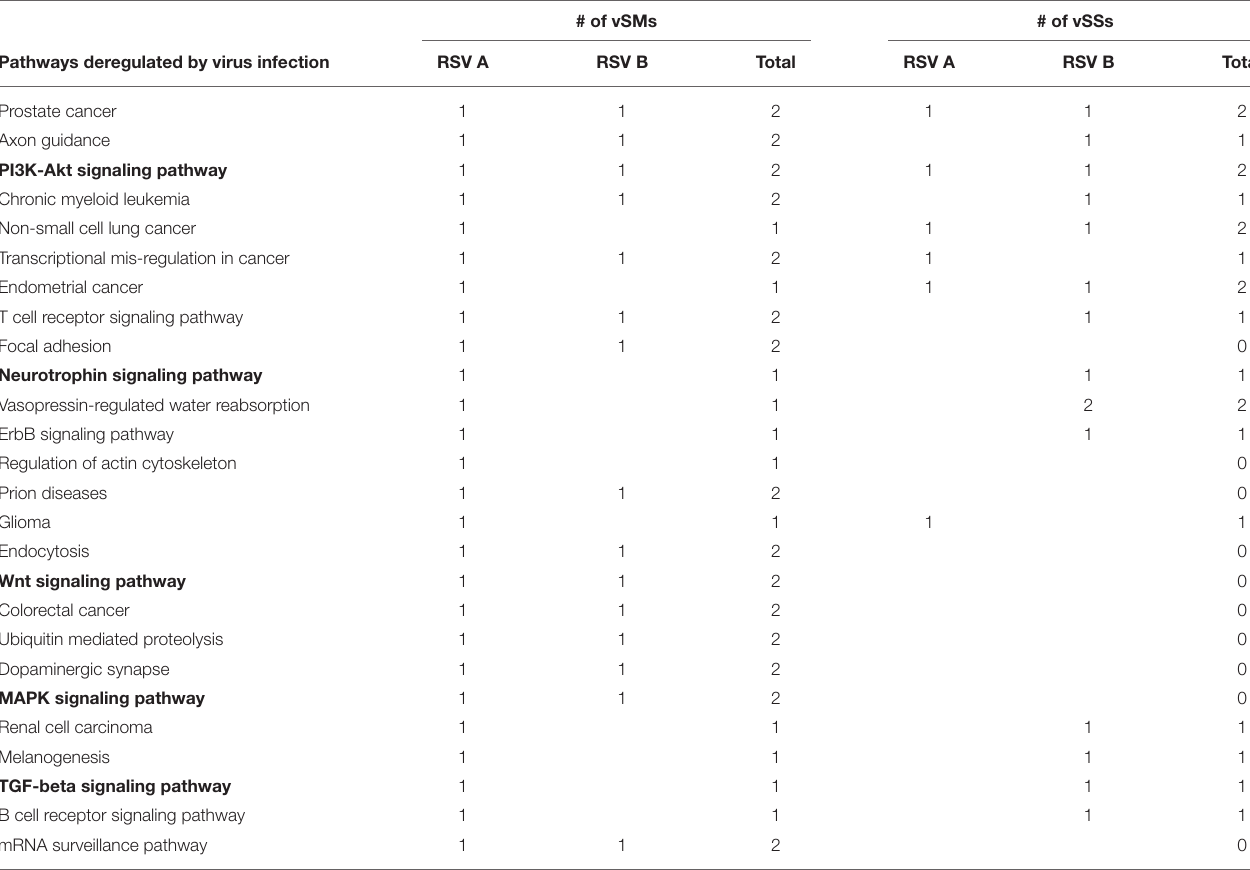
TABLE 4 | miRs targeted by vSMs and vSSs for HMPV or RSV strain A or B were analyzed by DIANA miRPath